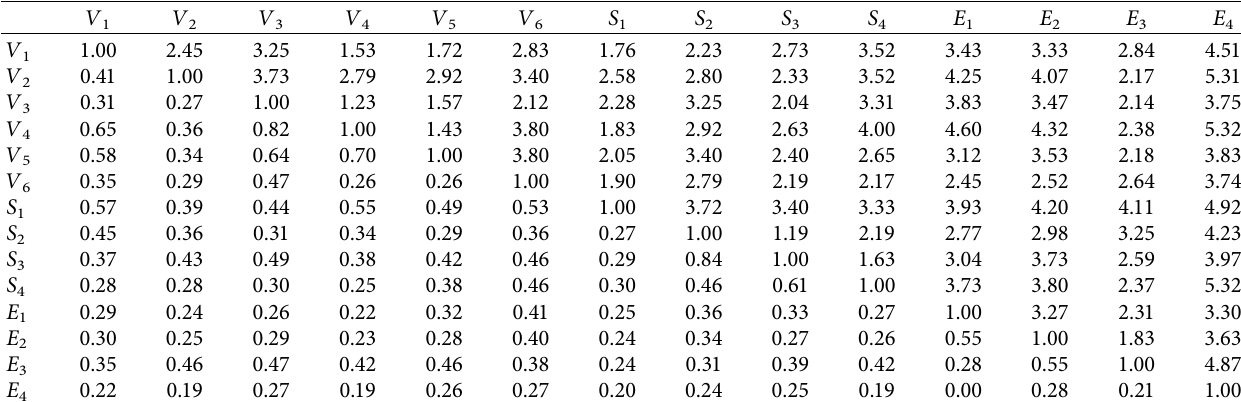
Table 6: Pairwise comparison on subfactor